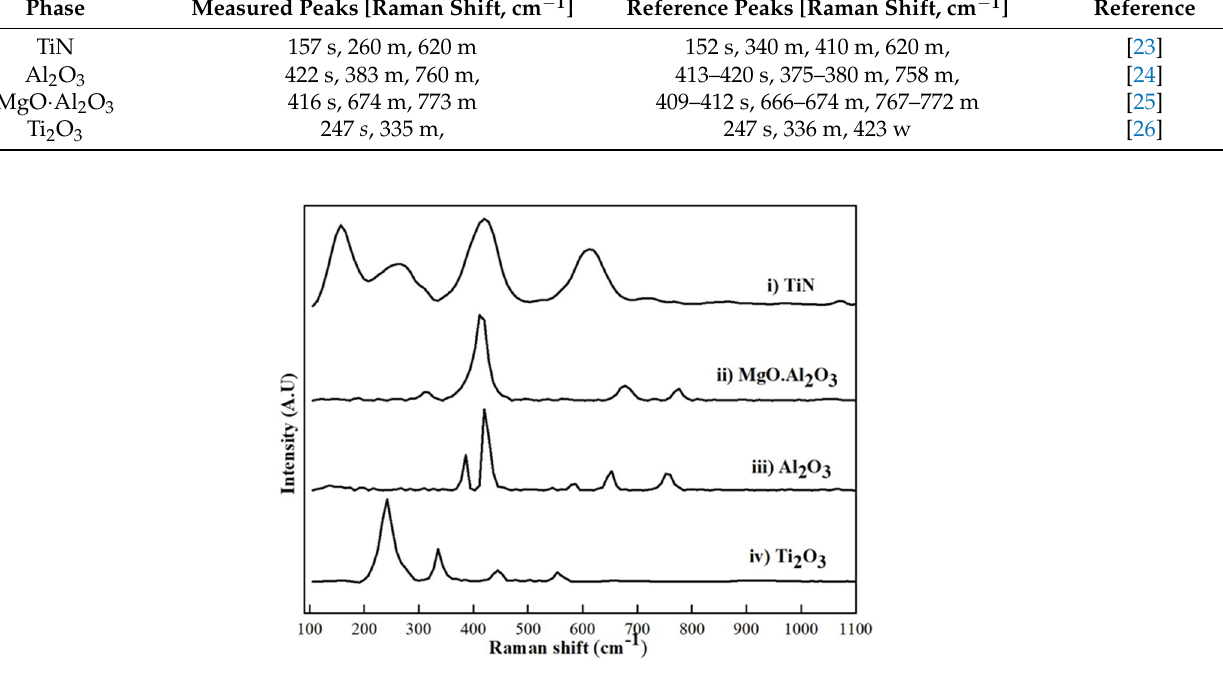
Figure 1. The starting sample phases of TiN, MgO · Al 2 O 3 , Al 2 O 3 , and Ti 2 O 3 Raman spectra used to prepare binary samples for this study.